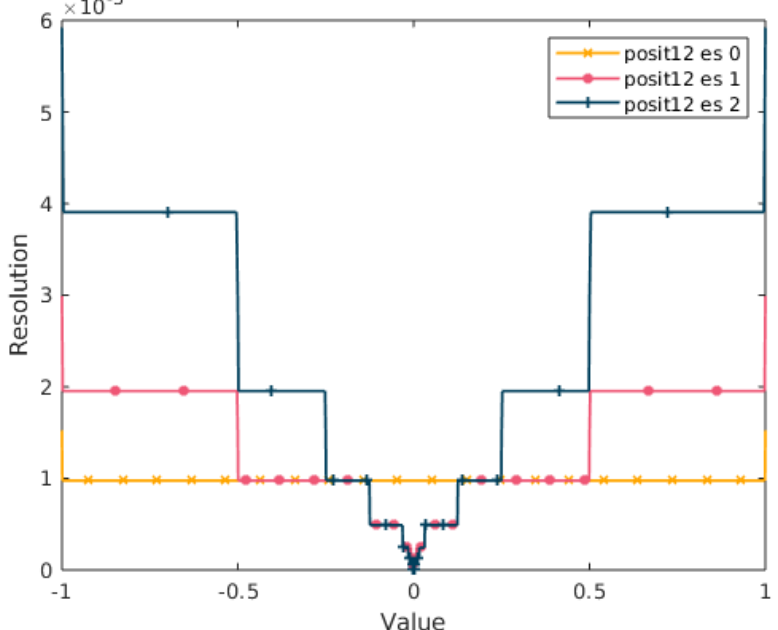
Figure 3. Resolution of a 12-bit Posit when varying the exponent size. With a 0-bit exponent, the Posit resolution in the [ 0,1 ] range is the one of a 12-bit fixed point